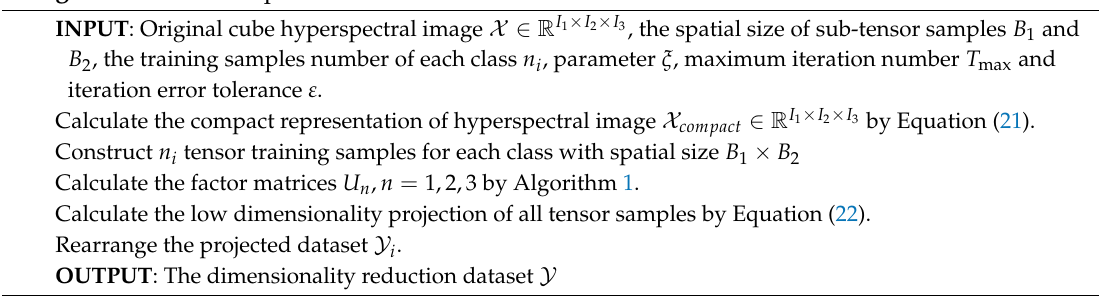
Algorithm 2: The Proposed